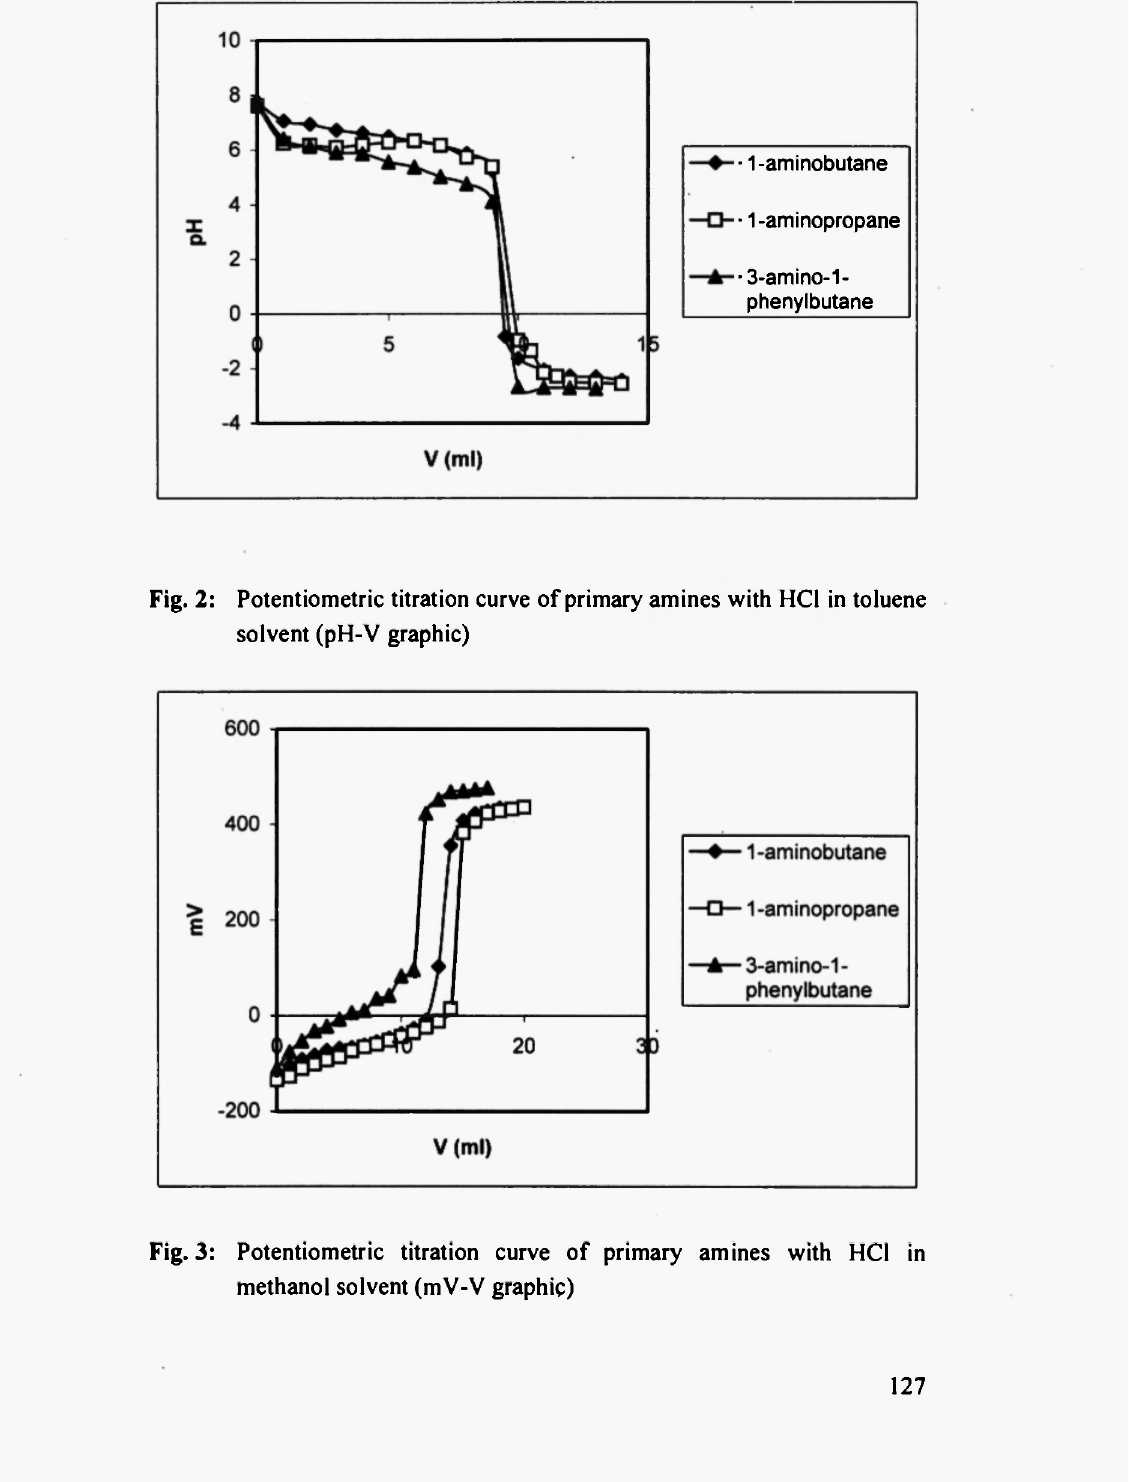
Fig. 2: Potentiometrie titration curve of primary amines with HCl in toluene solvent (pH-V graphic)